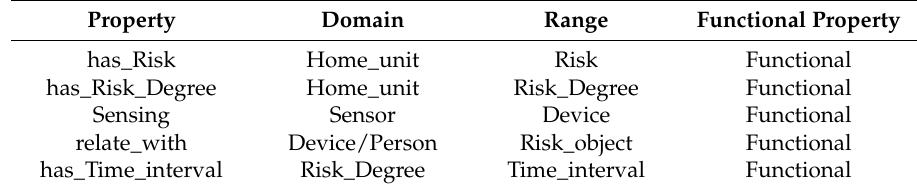
Figure 8. Ontology view focusing on service knowledge.